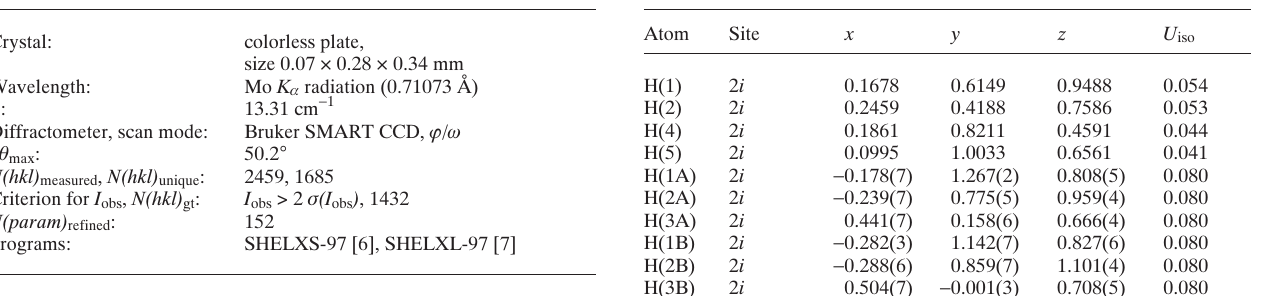
Table 2. Atomic coordinates and displacement parameters (in Å 2 ) .